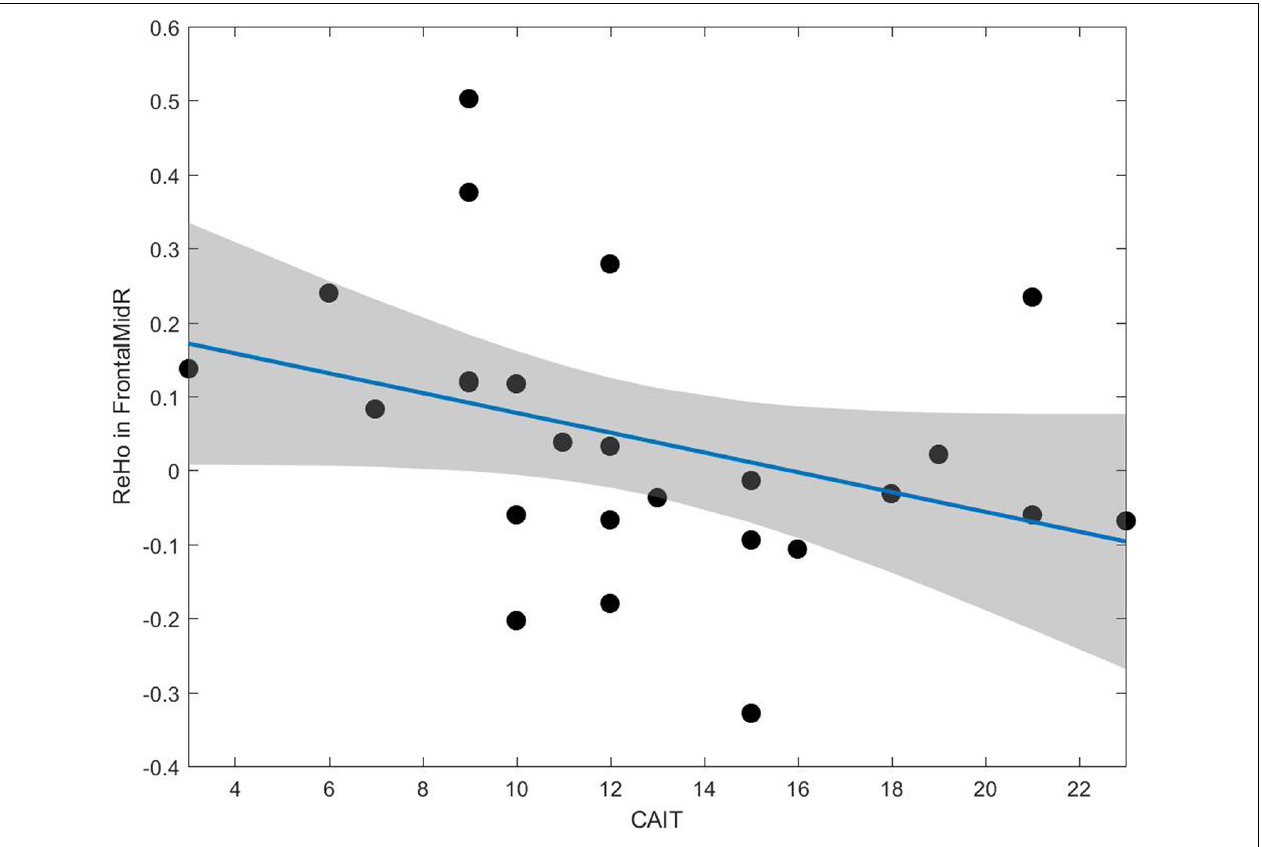
FIGURE 5 | A negative correlation between the CAIT and ReHo value can be observed in the middle frontal gyrus ( r = –0.52, p = 0.007).